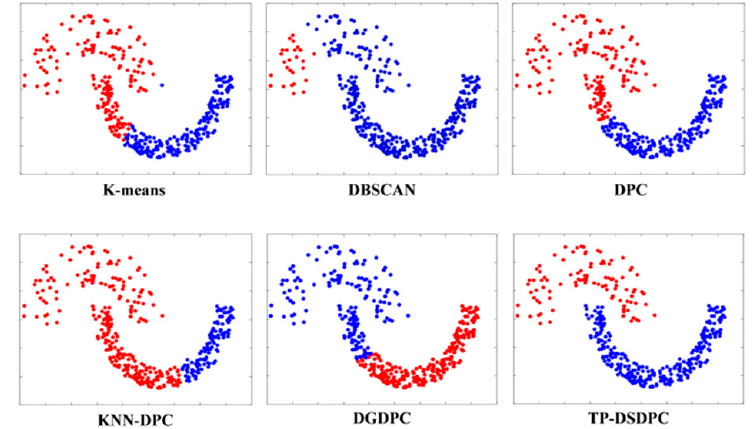
Figure 7. Clustering results on Jain.